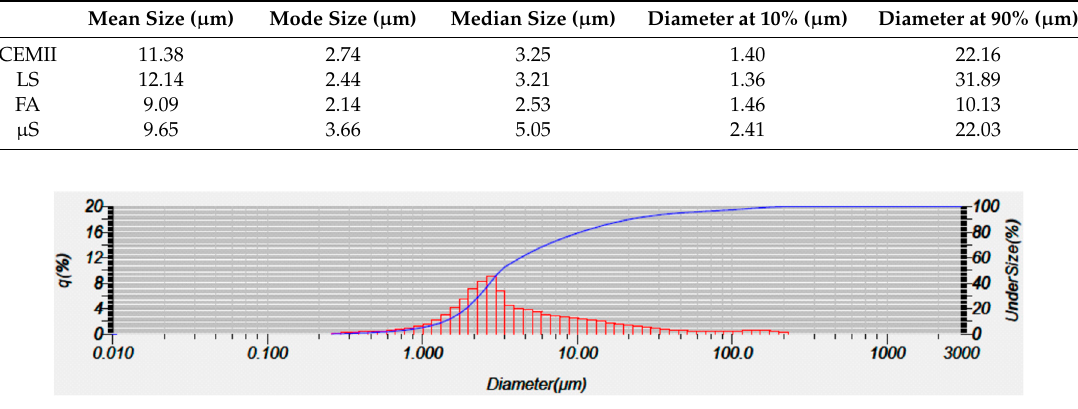
Figure 4. Normal distribution of CEMII.